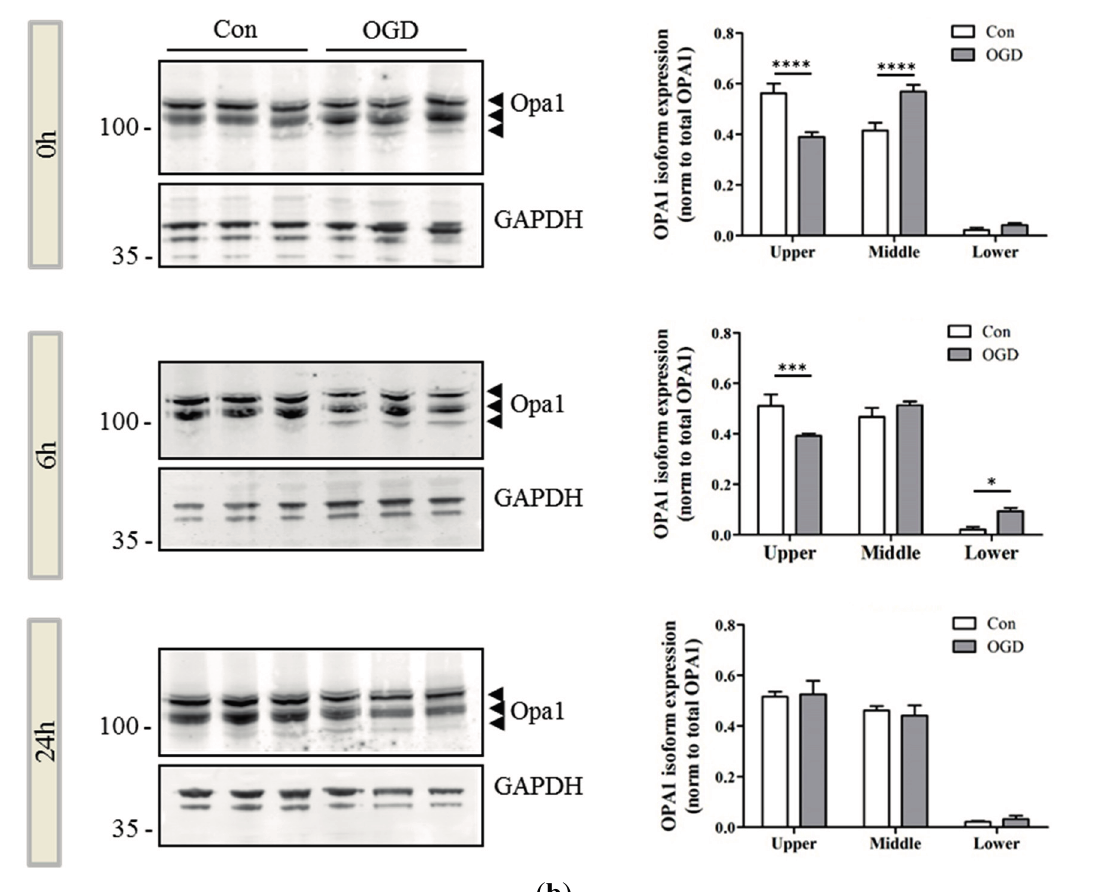
Figure 2. OPA1 processing is altered after OGD ( a ) mRNA generated from control (white bars) and OGD-treated (grey bars) primary neurons was analyzed by qRT-PCR for changes in expression of fission ( Drp1 , Fis1 ) and fusion genes ( Mitofusin 1 and 2 , OPA1 ). There was a small but significant decrease in OPA1 expression in response to OGD exposure ( a = 0.0296). Mean data shown ± SD ( n = 4–5 independent litters), significance determined by two way ANOVA; ( b ) Protein lysates were generated from primary neurons either immediately after 90 min OGD (0 h) or following 6 or 24 h recovery. Proteins were resolved by SDS-PAGE and OPA1 analyzed by western blot. Equal protein loading was determined by GAPDH expression. Size distribution of the OPA1 immunoreactivity is expressed as a proportion of total OPA1 (arrowheads). There was a significant increase in the expression of the OPA1 lower band at 0 and 6 h, significance determined by two-way ANOVA for treatment and band. If there was a significant interaction, a Bonferroni post-hoc was performed. Data are mean ± SD ( n = 3 independent litters), * p < 0.05, *** p < 0.001, **** p <